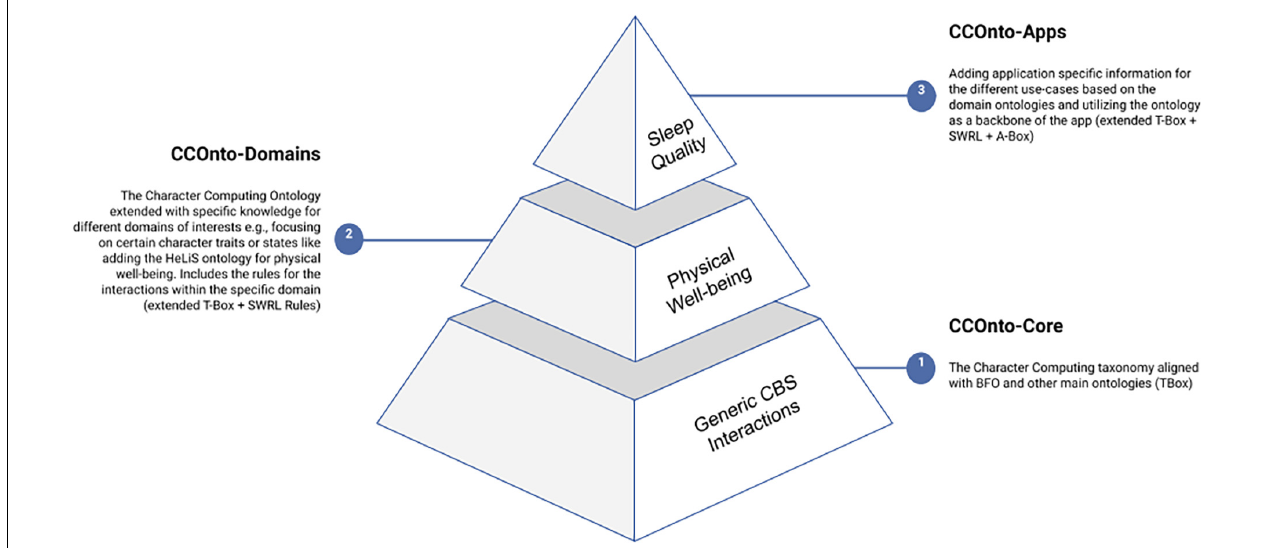
FIGURE 2 | The three interconnected artifacts of the Character Computing